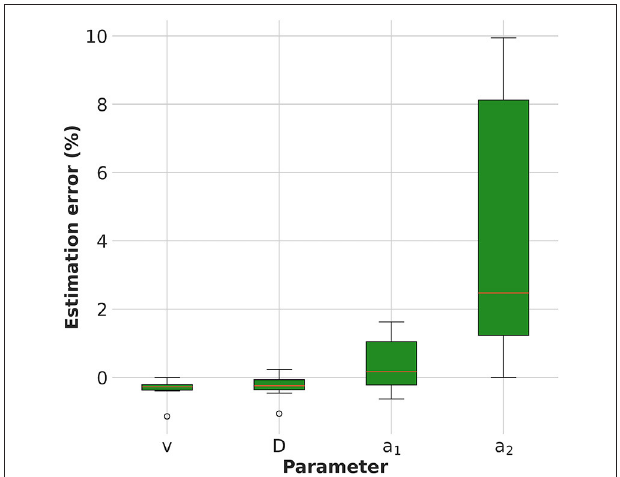
FIGURE 2 | Numerical verification of the KC-DA algorithm: estimation error of the model